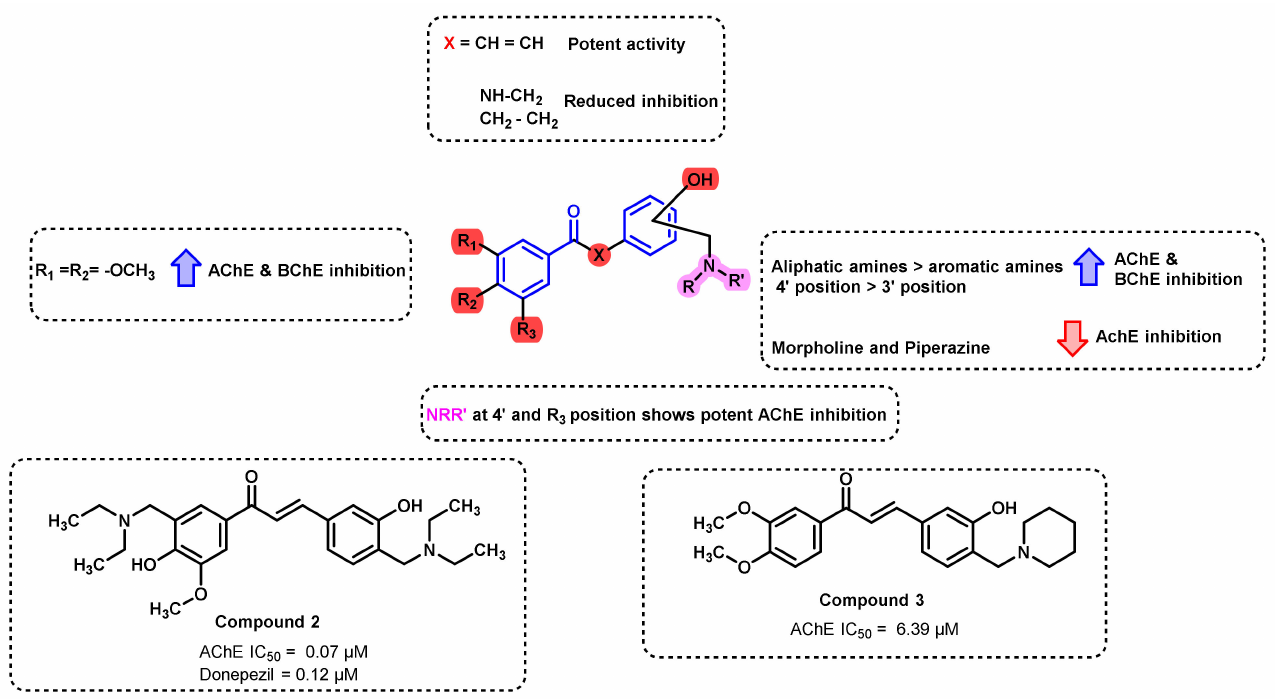
Figure 9. Mannich bases-derived chalcone reported by Zhang et al. A series of 4-amino chalcones were synthesized by Gurdere et al., by replacing the B ring with various substituted phenyl and heterocyclic rings (Figure 10) [44]. All of the synthesized compounds showed higher potency for AChE inhibition (222.47–1048.41 nM) than the standard tacrine (IC 50 = 1143.312 nM), but none of the compounds showed good activity against BChE. The phenyl ring substituted with EDG demonstrated a higher potency (compounds 4 and 5). The replacement of the phenyl B ring with heterocyclic rings like furan and thiophene decreased the ChEs inhibitory activities to a larger extent